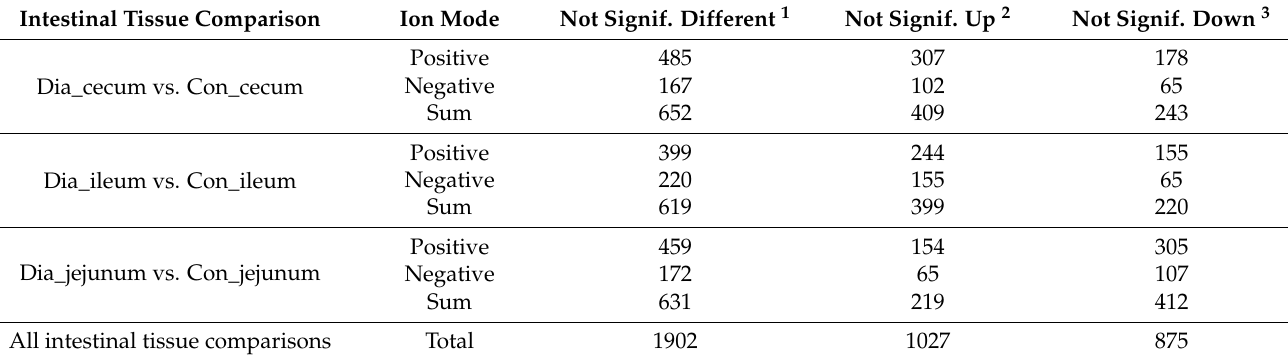
Table 1. In the cecum, ileum, and jejunum, the number of metabolites in diarrhea (Dia) group (not significantly different 1 ) was significantly higher than that in normal (Con) group (not significantly up 2 ). The number in the Dia Group was significantly lower than in the Con Group (not significantly down 3